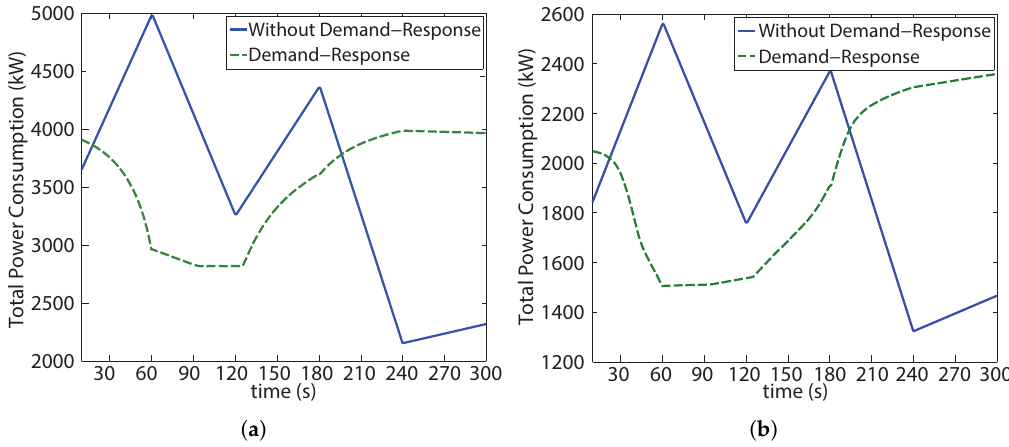
Figure 10. The power consumption in 13 and 34 node systems. ( a ) 13 Node system; ( b ) 34 Node system.